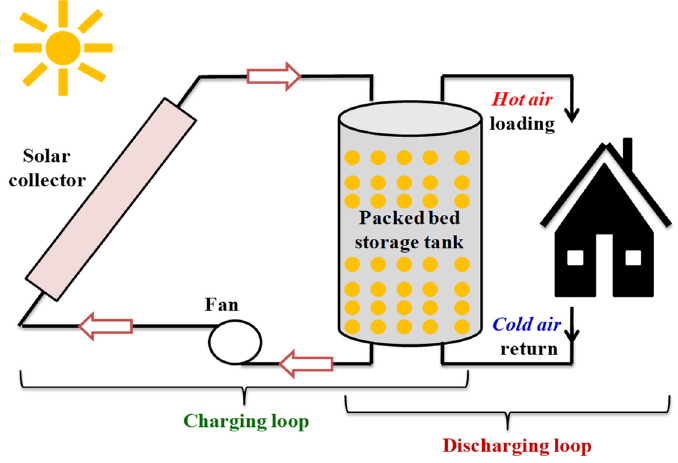
Figure 7. Heating application: porous packed bed SHS system, reprinted/adapted with permission from Ref. [3], 2022, Springer Nature.